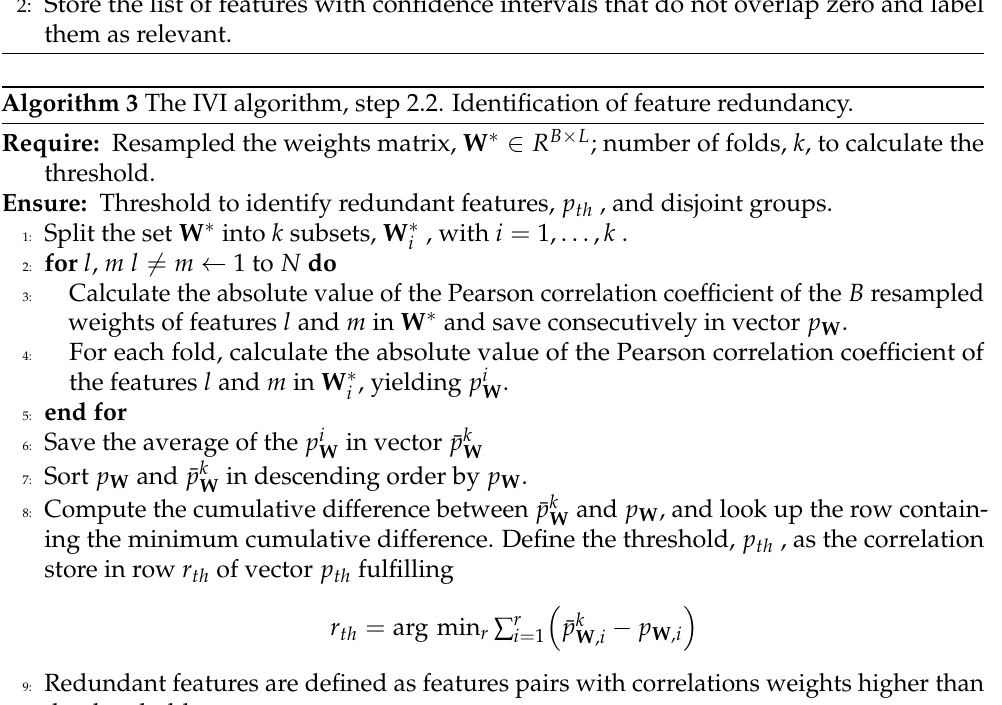
Algorithm 3 The IVI algorithm, step 2.2. Identification of feature